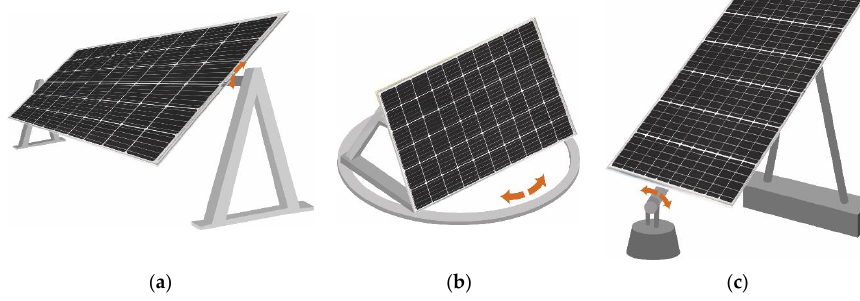
Figure 6. Single-axis photovoltaic tracking systems: ( a ) HSAT, ( b ) VSAT, and ( c ) TSAT.